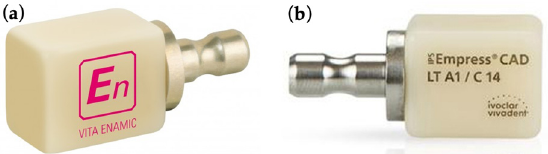
Figure 1. Chairside CAD/CAM C14 blocks: ( a ) VE and ( b ) EC.